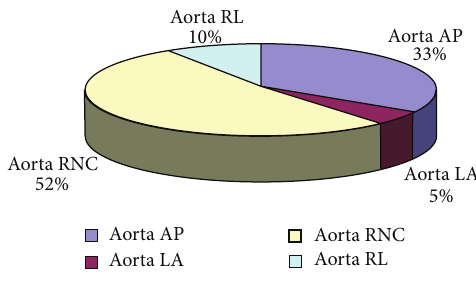
Figure 6: Presence of different BAV morphological patterns in ex- athletes group. AP: anteroposterior; LA: lateral; RL: right left; RNC: right noncoronary: LNC: left